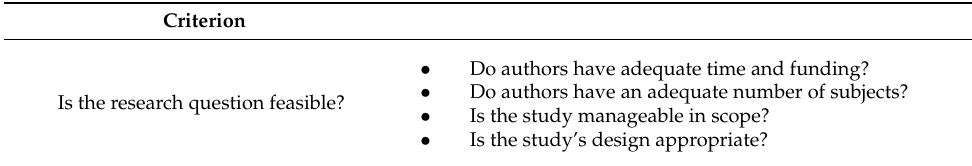
Table 1. FINER criteria for developing the research